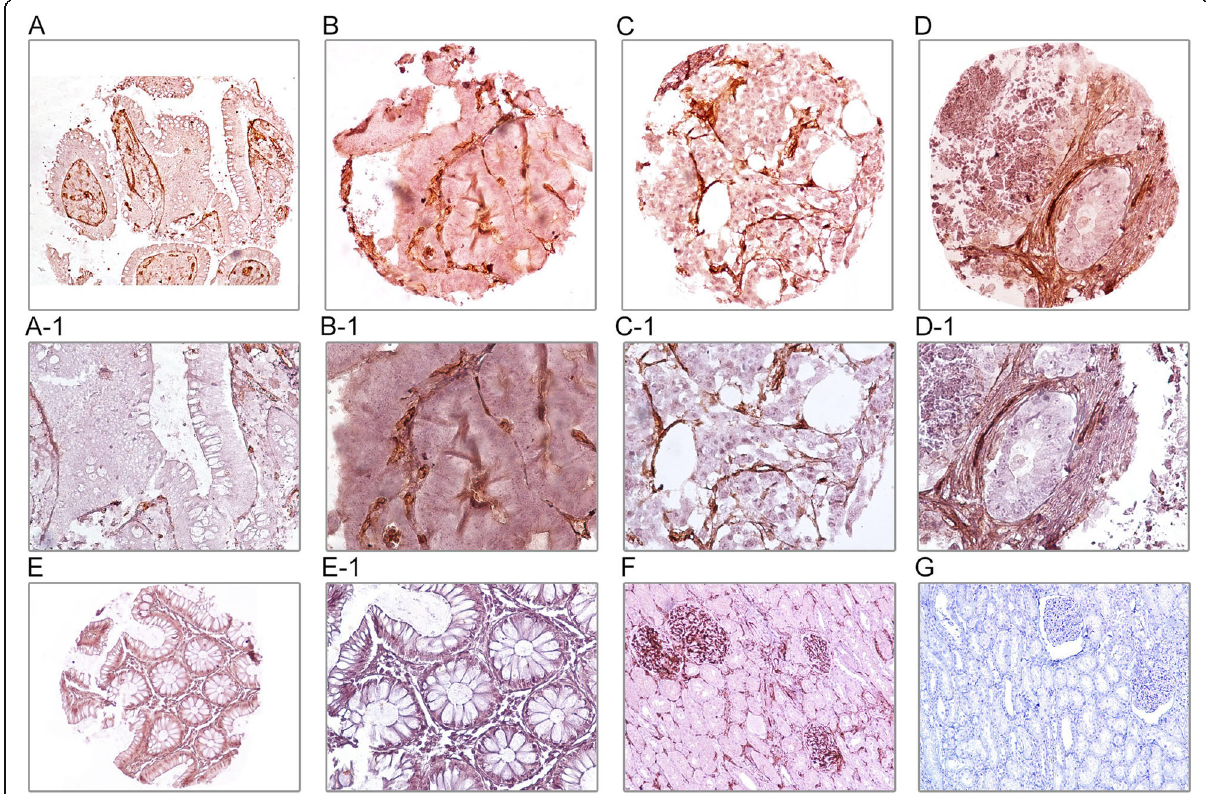
Fig. 2 Immunohistochimecal staining of CD105 in colorectal cancer tissues (CRC), adjacent normal tissues, and normal testis controls. Cytoplasmic CD105 expression in tumor cells: low expression a-a1 and high expression b-b1 . CD105 expression in endothelial cells: low expression c-c1 and high expression d-d1 . Adjacent normal tissues e-e1 . Normal kidney tissues as controls: positive f and negative